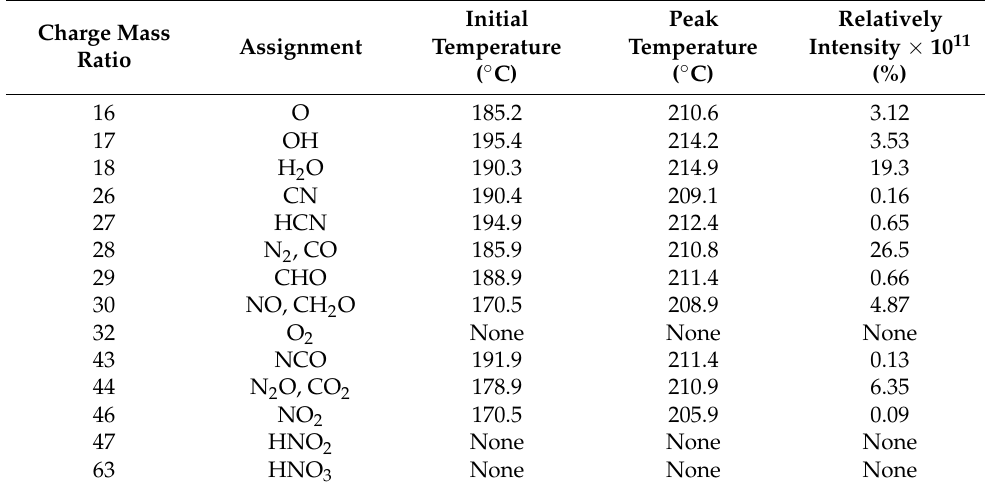
Table 5. Fragments and assignments of the thermal decomposition products of